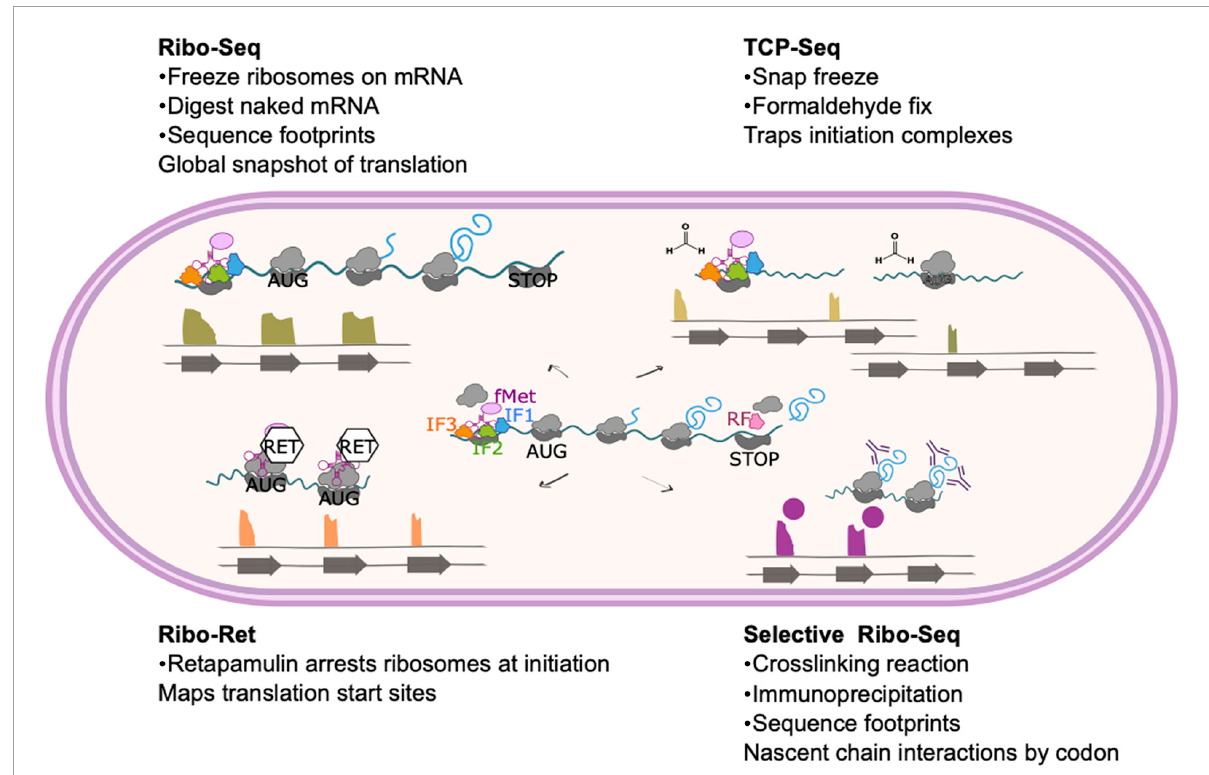
FIGURE1 Ribosome profiling method and modifications. The basic ribosome profiling method involves isolation and sequencing of mRNA that is protected from nuclease digestion by ribosome binding. As the central panel shows, these mRNA footprints represent codons across the entire gene often including non-coding regions such as the ribosome binding site. Read length and various in vitro and in silico selection methods can be applied to enrich for sequences that are more likely to represent active translation rather than non-productive ribosome binding. Variations on this method to select or enrich the library for particular features are shown. TCP-Seq (top right) includes flash freezing and formaldehyde fixation steps to trap initiation complexes. Reads from TCP-Seq therefore often map upstream of the CDS (reflecting formation of the canonical SD initiation complex) or at the start codon (for 70S initiation mechanisms). In ribo-RET (bottom left) cells are treated with retapamulin, which arrests ribosomes at initiation. This method can be used to identify unannotated translational start sites, including those within known coding sequences, such as IRES. Selective ribo-seq (bottom right) involves crosslinking ribosomes to their mRNA and any proteins interacting with the emerging nascent chain, such as trigger factor or other molecular chaperones. Translation complexes that have been trapped during interaction with the target protein are then isolated by immunoprecipitation. The footprints therefore correspond to mRNA that is translated as the nascent chain interacts with the target, indicating the length of nascent chain required for the